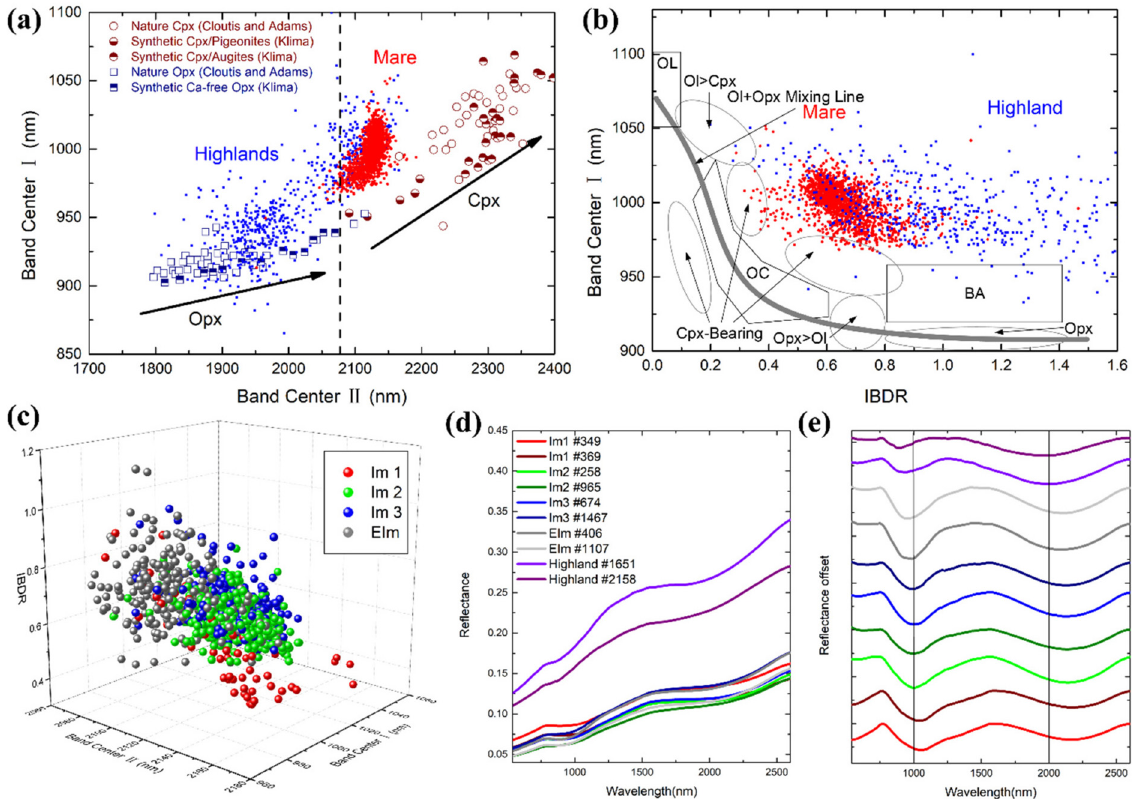
Figure 10. M 3 reflectance spectra and mineral compositions in the Crisium basin. ( a ) BC I versus BC II diagram of spectra of small craters in mare and highlands. Natural pyroxenes from Adams (1974) and Cloutis and Gaffey (1991) [60] and synthetic pyroxenes from Klima et al. (2011) [61] are also used to distinguish pyroxene composition. ( b ) BC I versus IBDR diagram modified from Gaffey et al. (1993) [62] and Varatharajan et al. (2014) [63]. Cpx: clinopyroxene; Opx: orthopyroxene; Ol: Olivine; OL: monomineralic olivine assemblages; OC: ordinary chondrites; BA: basaltic achondrite [62]. ( c ) The 3D scatter plot of pyroxene absorption bands and HCP/LCP ratios in four mare units ( Im1 , Im2 , Im3 , and EIm, which are defined in the next section). The representative spectra after smoothing ( d ) and continuum removal ( e ) from small fresh craters in four mare units and highland massifs are labeled in Figure